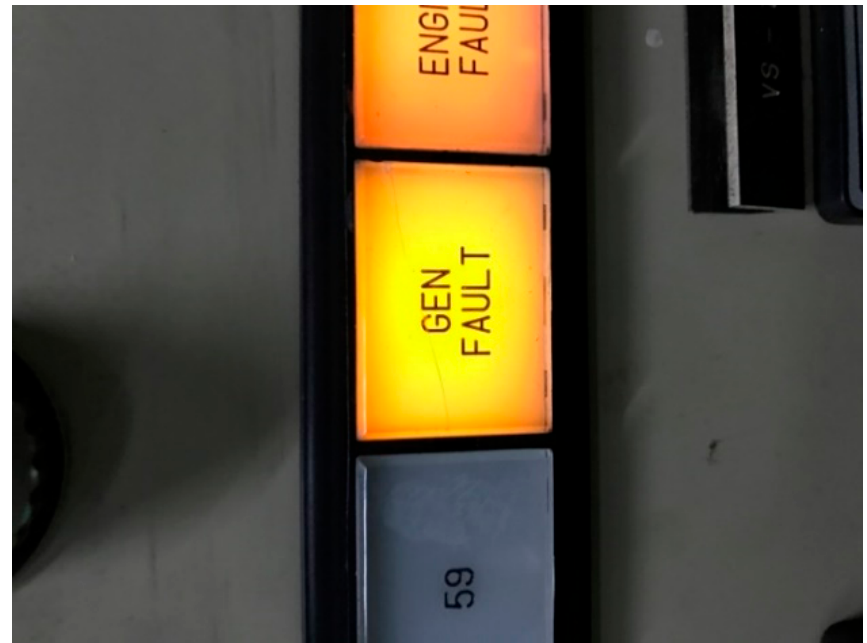
Figure 35. Operation of VCB panel.